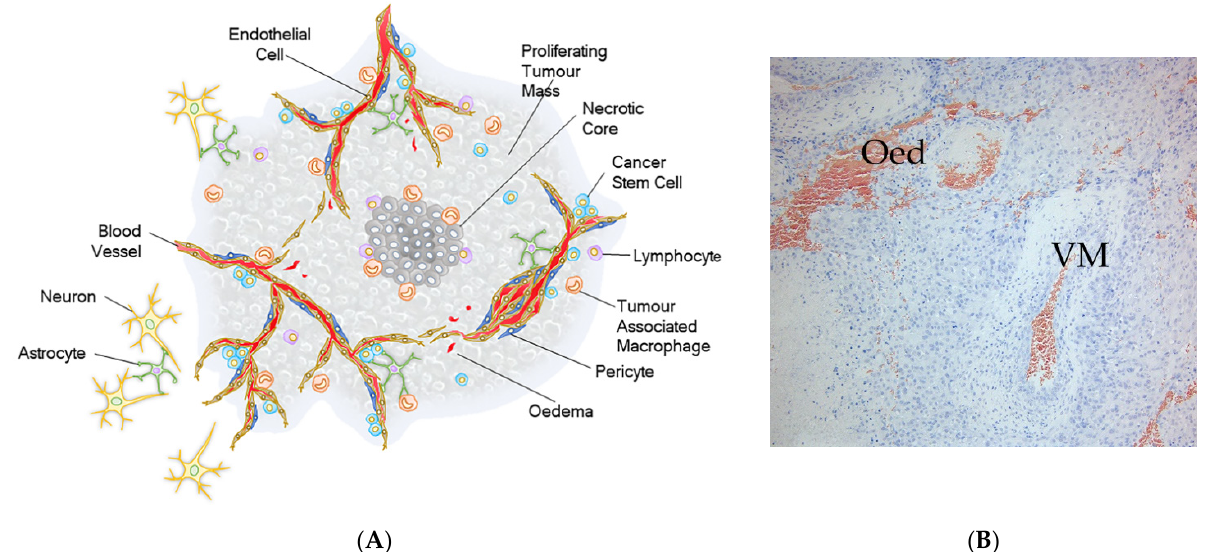
Figure 1. ( A ) Illustration of the major anatomical features of GBM [5]. ( B ) Haematoxylin & eosin stain of a tissue section of GBM with an example of vascular mimicry (VM) and oedema